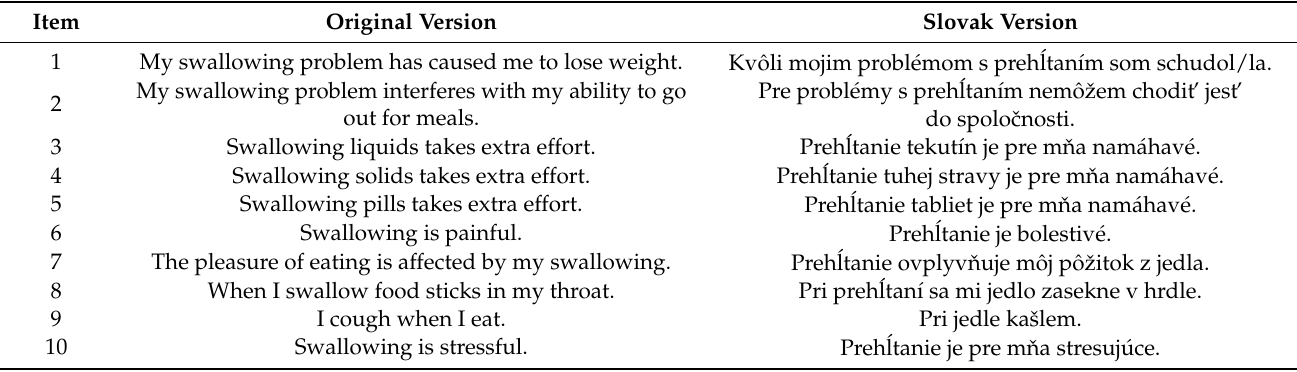
Table 1. The Slovak version of the Eating Assessment Tool (Slovak EAT10 ®